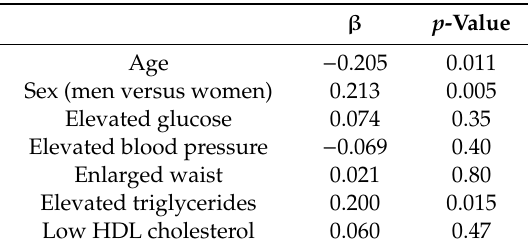
Table 3. Multivariable linear regression analysis demonstrating independent associations of plasma free thiols with age, sex and individual metabolic syndrome components in 168 subjects (79 Type 2 diabetic subjects and 89 non-diabetic subjects). β p -Value Age − 0.205 0.011 Sex (men versus women) 0.213 0.005 Elevated glucose 0.074 0.35 Elevated blood pressure − 0.069 0.40 Enlarged waist 0.021 0.80 Elevated triglycerides 0.200 0.015 Low HDL cholesterol 0.060